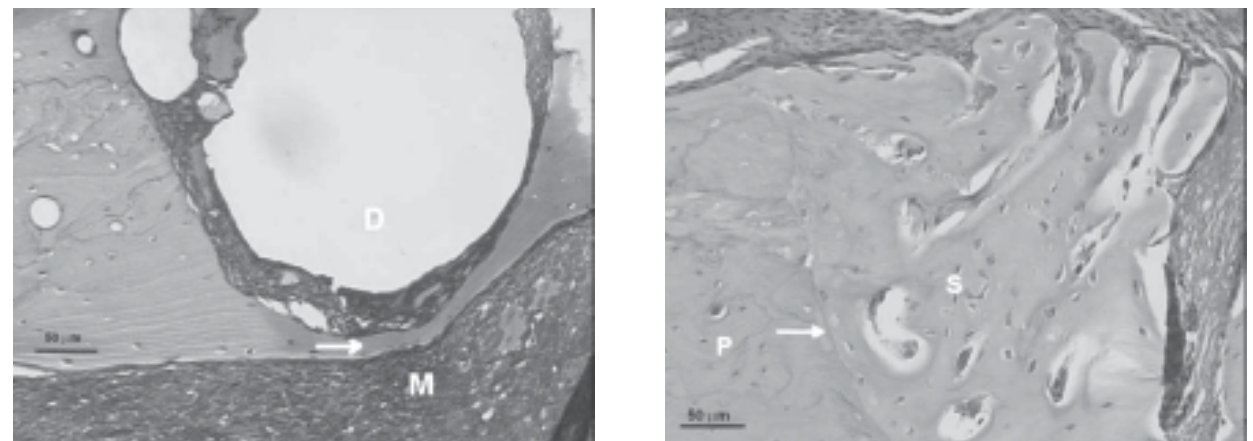
FIGURE 1- Photomicrographs of the surgically-created (unfilled) defects in rat tibia. In A , 1 day after surgery. The arrow indicates a thin layer of cortical bone between the bottom of the defect ( D ) and the bone marrow ( M ). In B , 21 days after surgery. The arrow points a divisory line between the newly formed bone (primary bone, P ) and the old, normal bone (secondary bone, S ). Haematoxylin-eosin